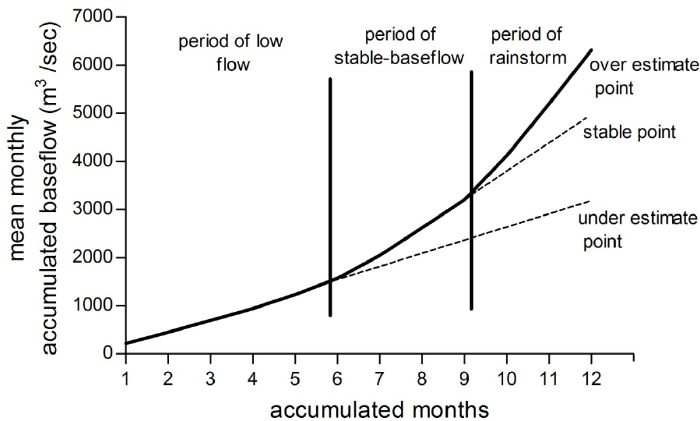
Figure 4. The diagram of the stable base-flow